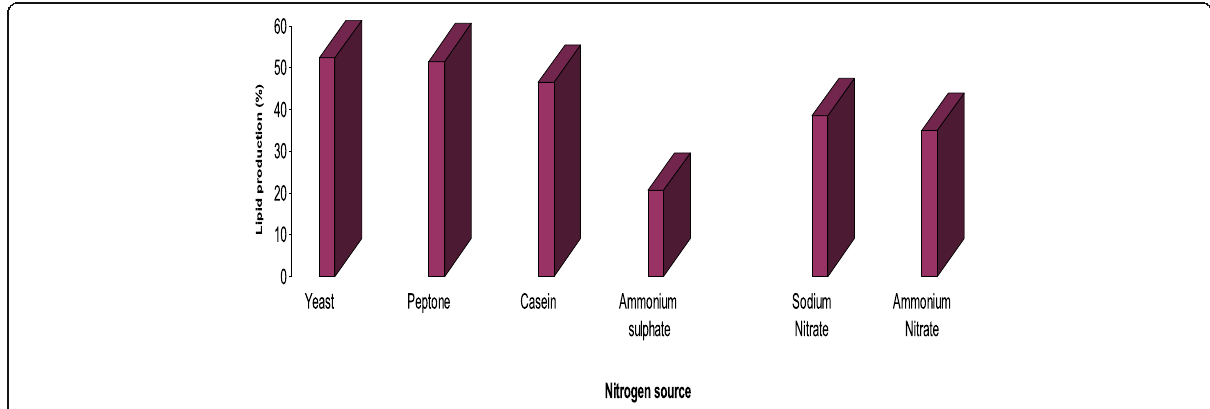
Fig. 9 Effect of different nitrogen sources on F. oxysporum NRC 2017 lipid production